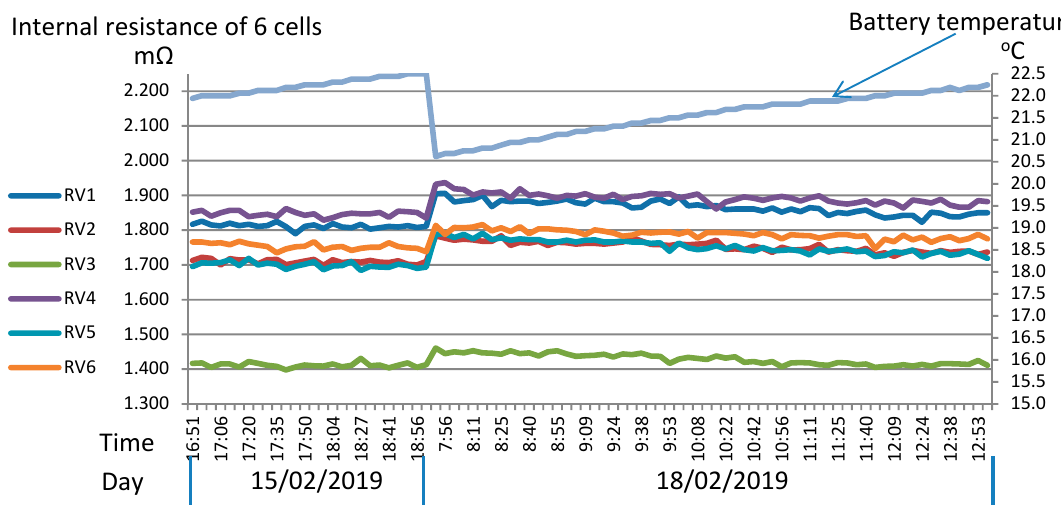
Figure 7. Results of measurements in the laboratory: resistance of 6 cells vs. temperature.